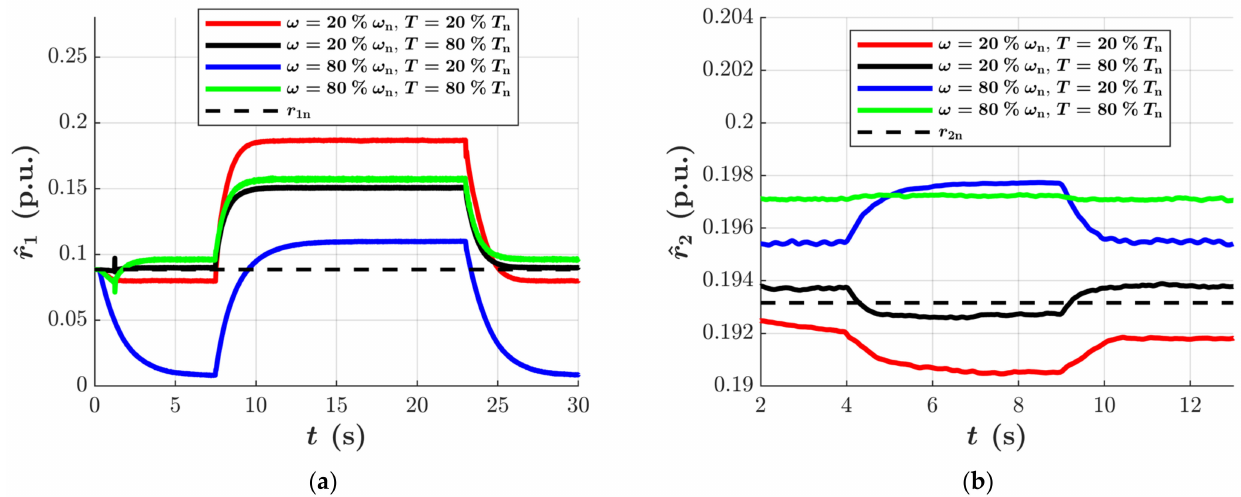
Figure 9. The effect of inverter nonlinearities on the performance of MRAS-type estimators ( ω n denotes the nominal electrical rotor angular speed, T n denotes the nominal torque, and r 1 n and r 2 n are the nominal stator and rotor resistance, respectively). ( a ) P-MRAS for stator resistance estimation; ( b ) Q-MRAS for the rotor resistance estimation. In the case of the P-MRAS, the inverter nonlinearity is activated at 7.5 s and deactivated at 23 s, and, in the case of the Q-MRAS, the inverter nonlinearity is activated at 4 s and deactivated at 9